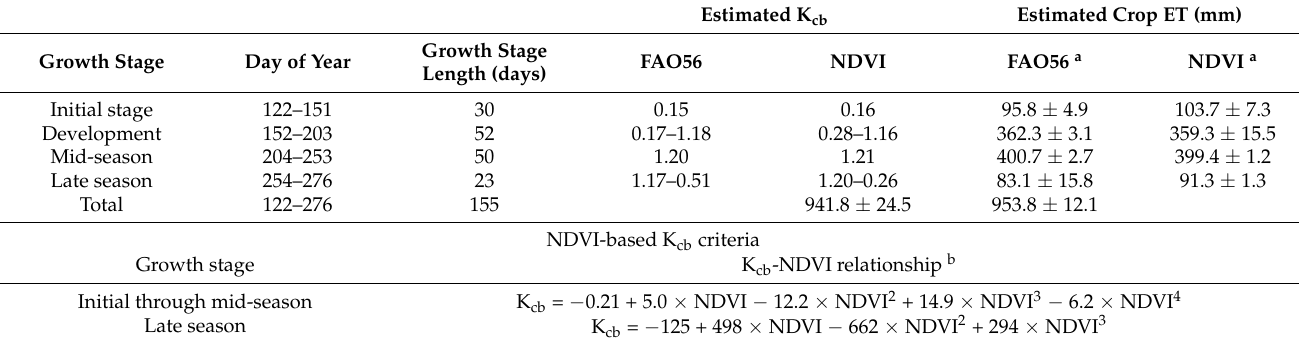
Table 3. Parameters describing the FAO56 basal crop coefficient (K cb ) curve and the NDVI-based K cb used in irrigation scheduling for the 2007 cotton experiment in Maricopa,